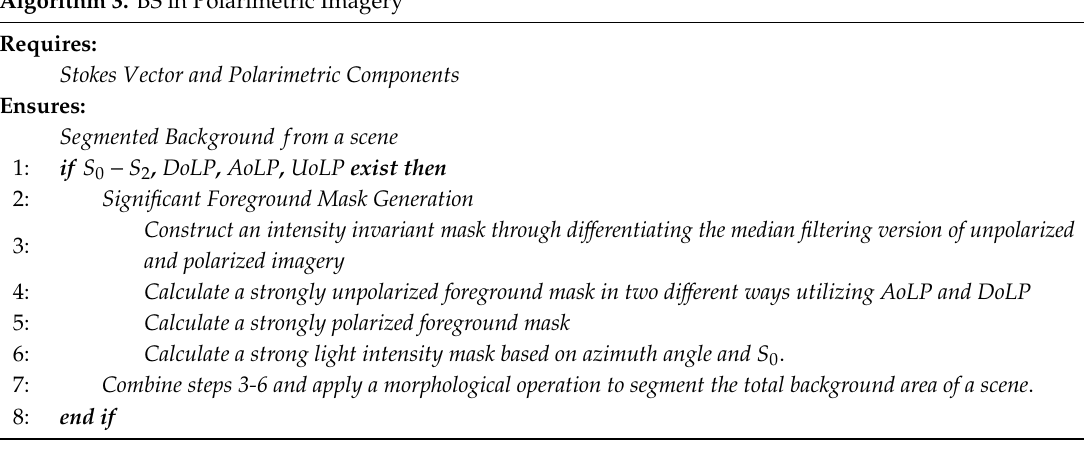
Algorithm 3. BS in Polarimetric